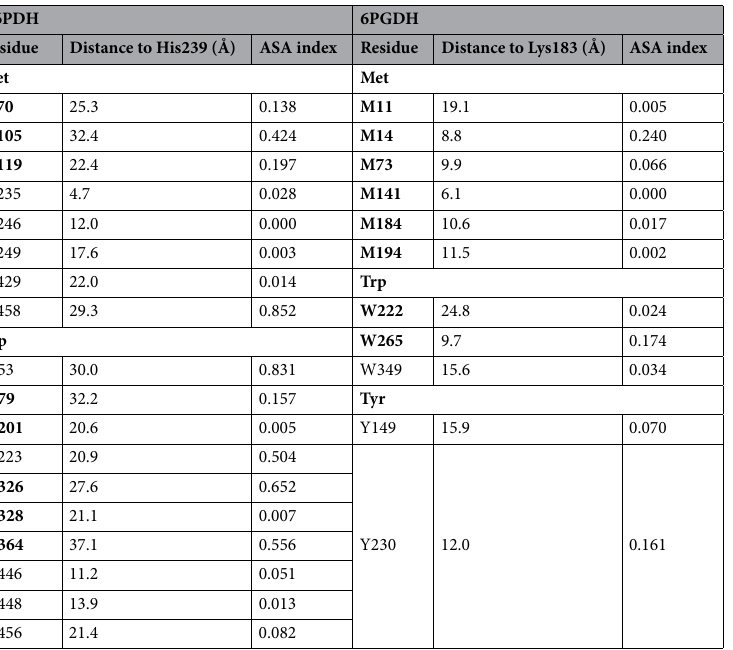
Table 5. Distance between catalytic amino acids (His239 for G6PDH, Lys183 for 6PGDH), and the amino acids detected as modified species, and their respective solvent exposures, are presented. The amino acids with modifications > 50% (see Fig. 7) believed to be involved in the loss of activity elicited by ROO Bold text. These residues were selected on the basis of their proximity to His239 (G6PDH) or Lys183 (6PGDH) and/or their solvent exposure (determined by ASA index, 0–1). Analyses were carried out using the protein sequences reported in UniProt database entries P0AC53 and P00350, for G6PDH and 6PGDH, respectively. The sidechains of the catalytic site His239 (imidazole ring) and Lys183 (nitrogen atom) were used to calculate the distance to the Met (sulfur atom) and Trp (indole ring) residues of the oxidized